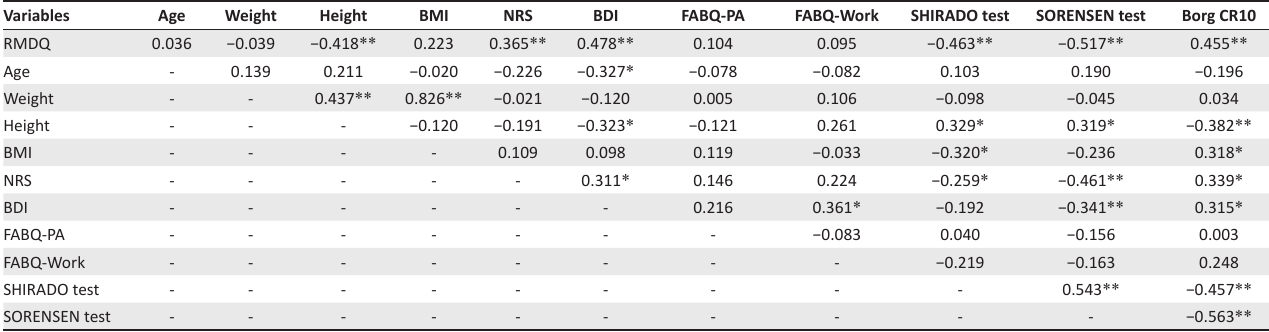
TABLE 3: Pearson and Spearman correlation between low back pain disability and biopsychosocial factors ( n =58). Variables